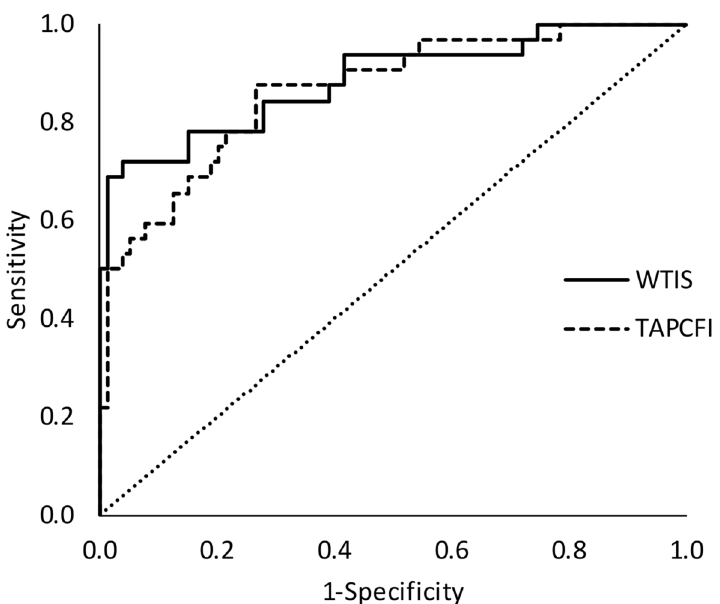
Figure 2. ROC Curves for Diagnostic ability to detect SDB patients (n: 78) against controls (n: 32) according to wrist temperature stability (WTIS, continuous line) versus TAP robustness (TAPCFI, discontinuous